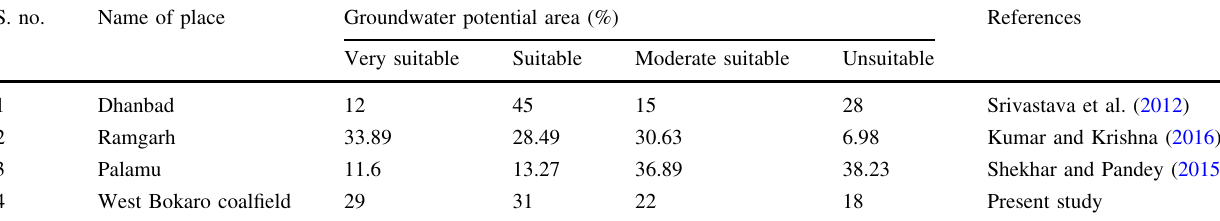
Table 3 Comparison of groundwater potential zone of the West Bokaro coalfield with other studies done in Jharkhand, India S.